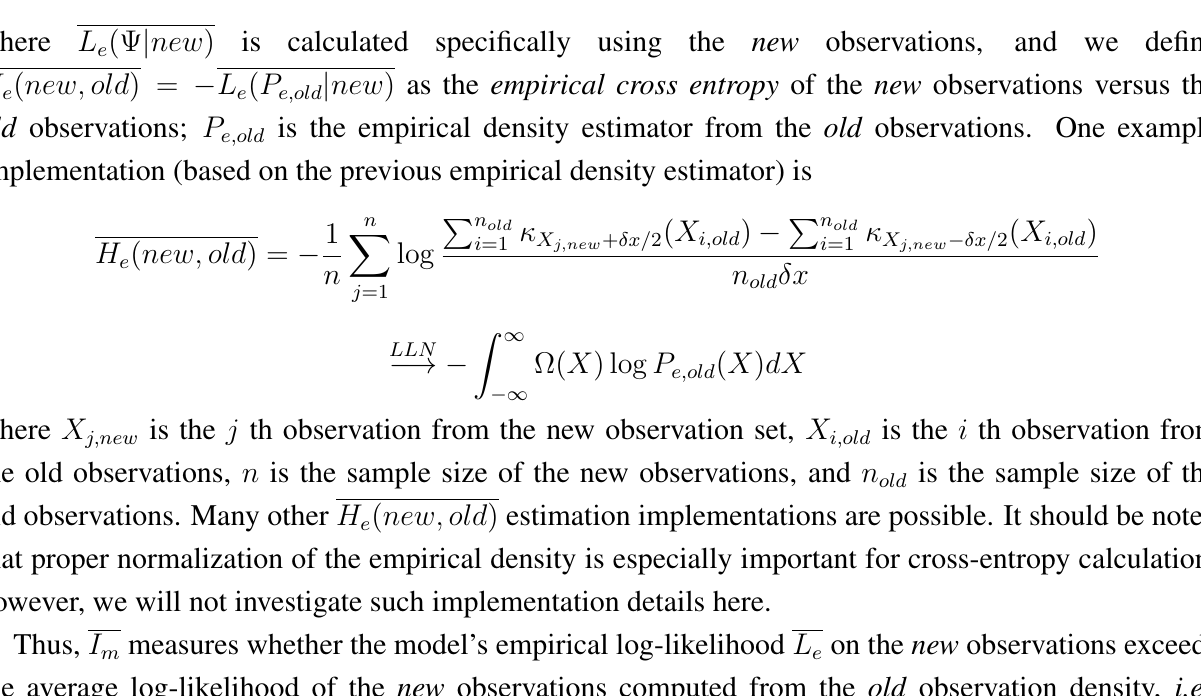
Figure 3: Model Information of the Normal Distribution . We draw n normal distribution N (0 , 1) and compute the posterior likelihood distribution for this sample. We